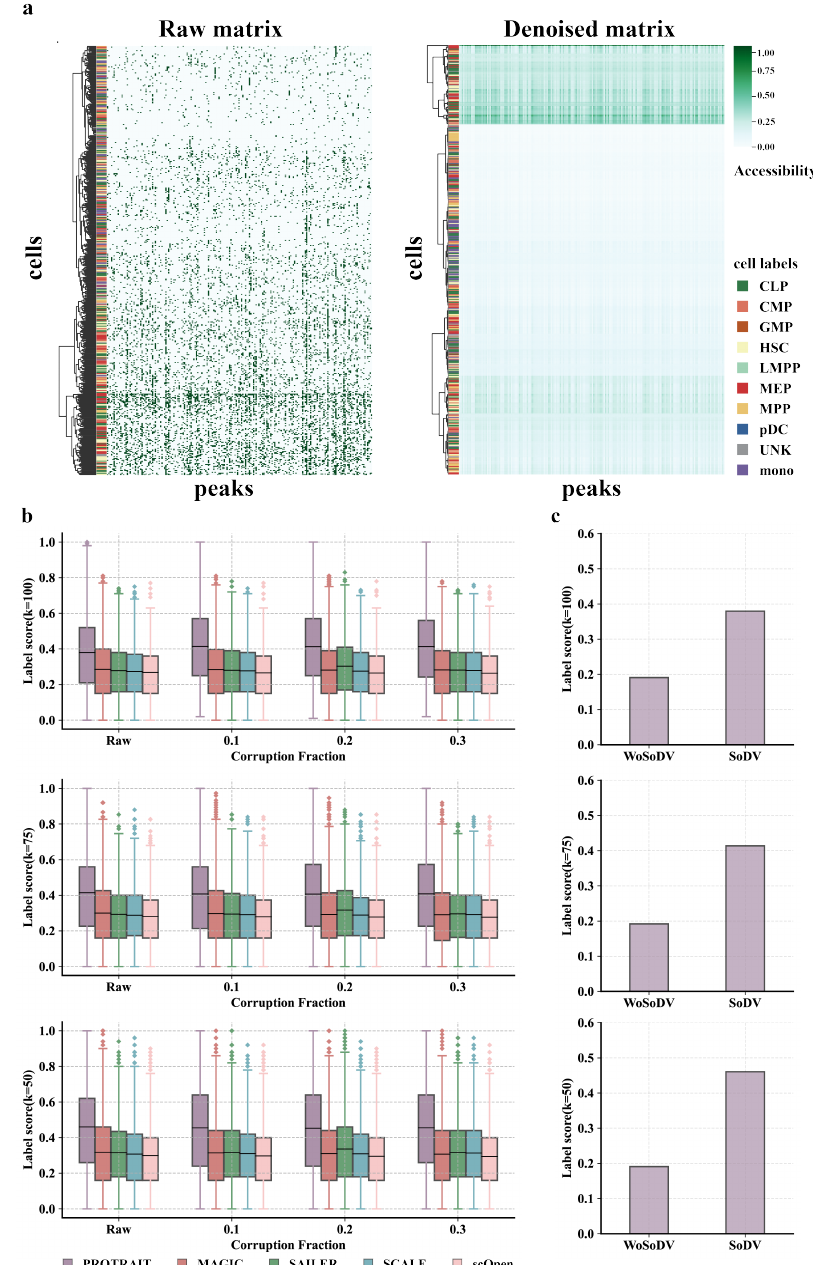
Figure 4. Performance evaluation of denoising approaches for scATAC-seq data. ( a ) The raw and de- noised peak-by-cell matrix of 800 peaks and 200 cells from the Buenrostro2018 dataset, hierarchically clustered by cells. ( b ) The label score (k = 50, 75, 100) comparison of PROTRAIT, MAGIC, SAILER, SCALE, and scOpen. ( c ) The label score (k = 50, 75, 100) comparison of PROTRAIT with search of dropout values (SoDV) and without search of dropout values